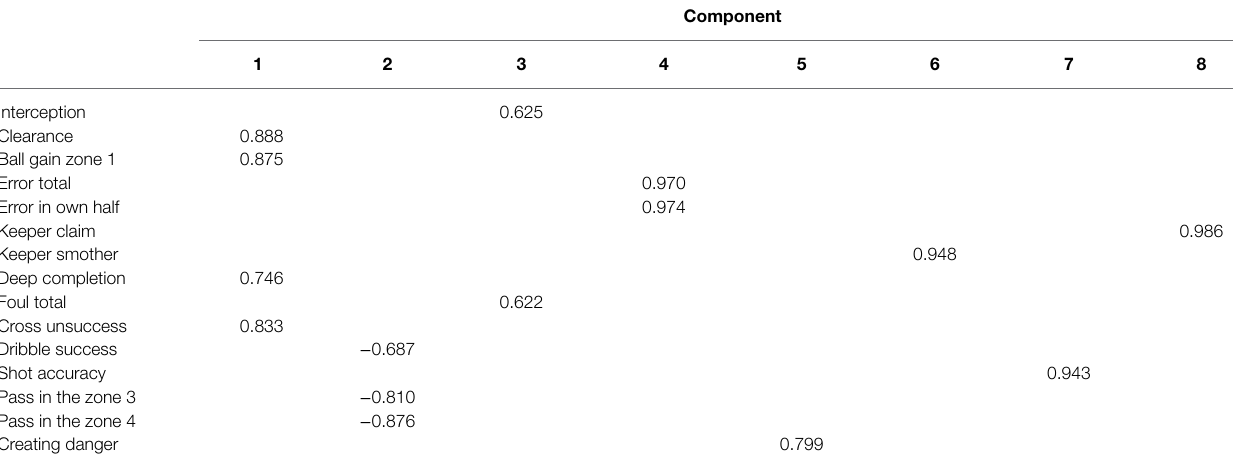
TABLE 2 | Rotated component matrix for the performance indicators showing a strong positive or negative